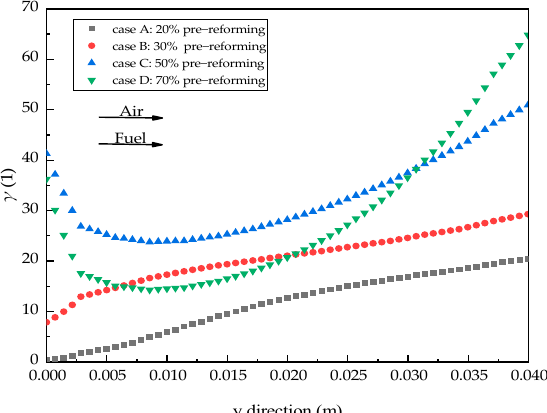
Figure 5. Distribution of γ along the middle section of AAL in the forward direction of y-axis under different methane pre-reforming percentages.